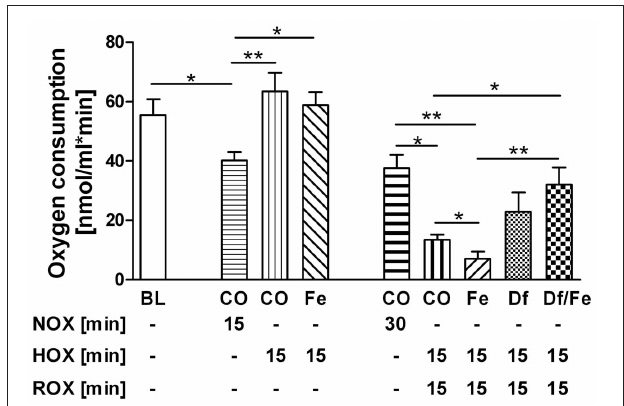
FIGURE 5 | Effect of HOX, ROX, and free iron on state 3 mitochondrial respiration rate. The baseline (BL) represents the respiration of freshly isolated mitochondria. Furthermore, mitochondria were incubated either under air (NOX) or under nitrogen (HOX) with 20 μ M FeSO 4 (Fe) or without (CO) for 15min. Subsequently, all samples were incubated under air for further 15min (ROX). A group of samples received 20 μ M desferrioxamine B (Df) immediately after onset of hypoxia. Data are expressed as mean ± SEM of at least n = 5. ∗ p < 0 . 05; ∗∗ p < 0 . 01. Abbreviations used: NOX, Normoxia; HOX, Hypoxia; ROX, reoxygenation; BL, Baseline; CO, control, Fe, FeSO 4 ; Df, desferrioxamine